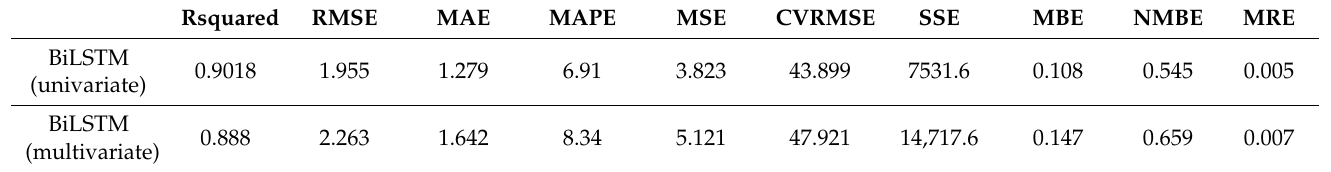
Table 5. Performance evaluation of the LSTM model for test data ( t msi = 60 s); LSTM 2